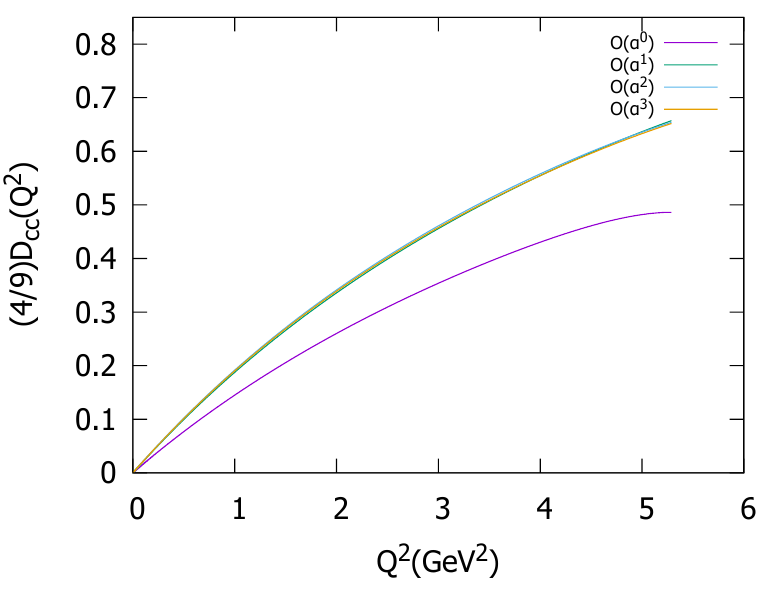
Figure 7 . D cc ( Q 2 ) at different orders in α s . The input value α ( n f =5) s ( M 2